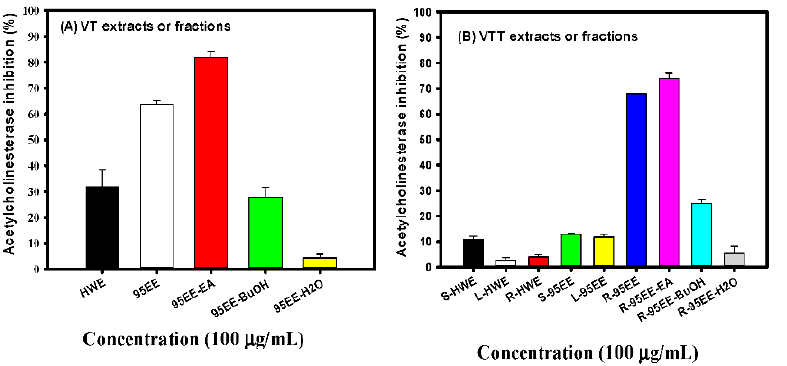
Figure 1. Effects of ( A ) VT-HWE, VT-95EE, VT-95EE-EA, VT-95EE-BuOH, and VT-95EE-H 2 O; and ( B ) HWE and 95EE of VTT-S, VTT-L, and VTT-R, and VTT-R-95EE-EA, VTT-R-95EE-BuOH, and VTT-R-95EE-H 2 O on acetylcholinesterase (AChE) inhibitory activities. The stem part of Vitis thunbergii Sieb. & Zucc. (VT) or the Vitis thunbergii var. taiwaniana (VTT) of different parts, root (VTT-R), stem (VTT-S), and leaf (VTT-L), each was extracted either by hot-water (HW) or 95% ethanol (95E) to get HW extracts (HWE) and 95EE. Data were expressed as mean ± SD of three independent quantitative